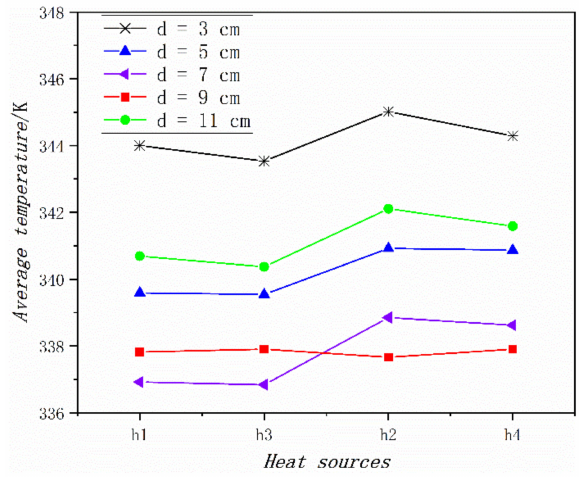
Figure 5. Temperature of different discrete heat